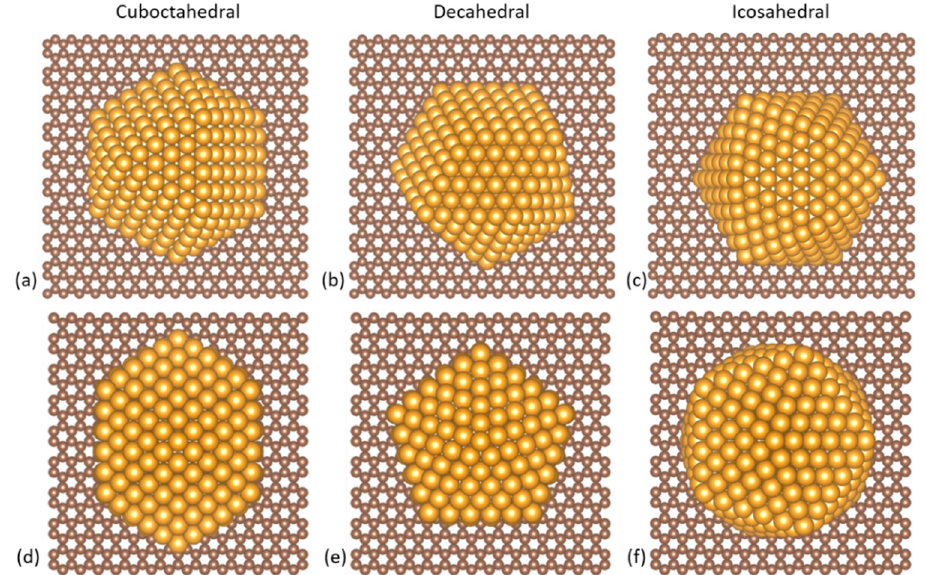
Figure 1. Top-down projections of the Au 561 NPs on graphene. First row: the ( a ) cuboctahedral, ( b ) decahedral and ( c ) icosahedral NPs with a (111) facet on graphene. Second row: the ( d ) cuboctahedral, ( e ) decahedral and ( f ) icosahedral NPs with a vertex on graphene.